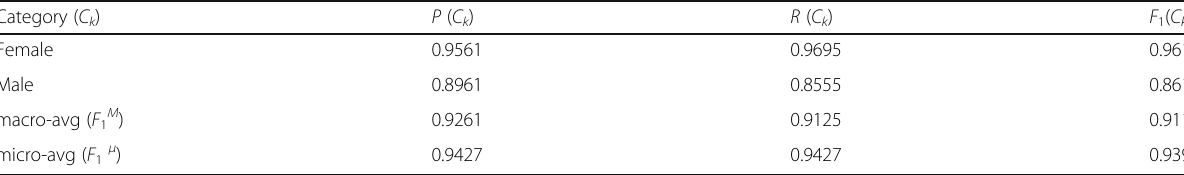
Table 11 Results with norm-TF with cross validation = 10